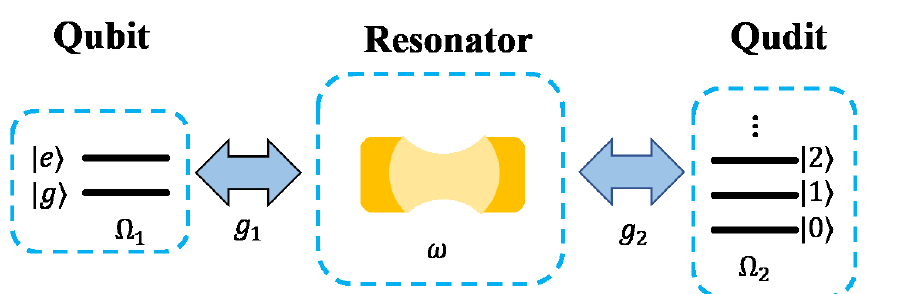
Figure 1: Model schematics. The system is composed of a qubit with level spacing Ω , an harmonic oscillator (resonator) with characteristic frequency ω , and a d -level 1 quantum system (qudit) with level spacing Ω to the resonator through the coupling constants g